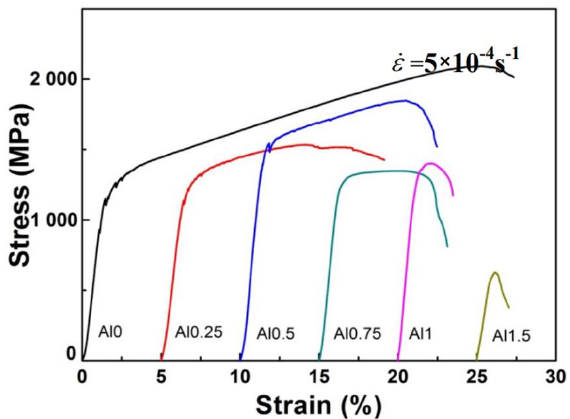
Figure 32. The engineering stress vs. engineering strain for the Al x NbTiMoV (x = 0, 0.2, 0.5, 0.75, 1, and 1.5) HEAs (reproduced from Reference